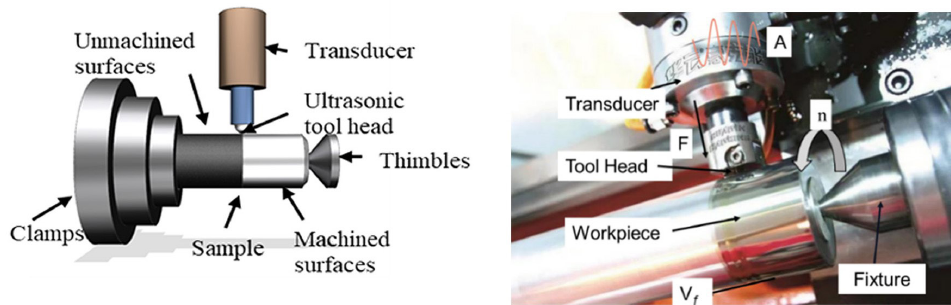
Figure 2. Ultrasonic surface rolling processing chart.